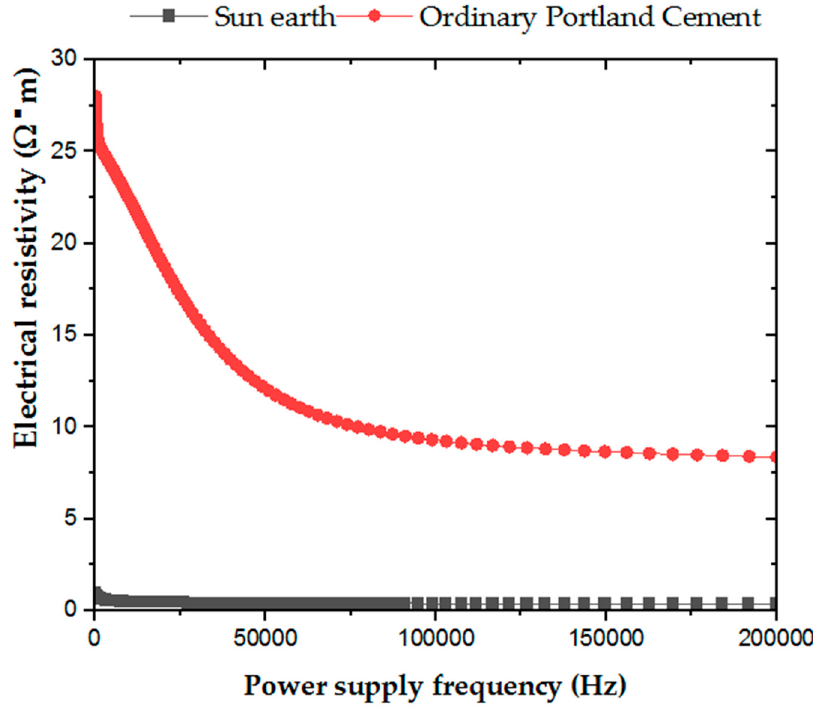
Figure 4. Resistivity versus frequency graph for sample OPC and San-Earth.